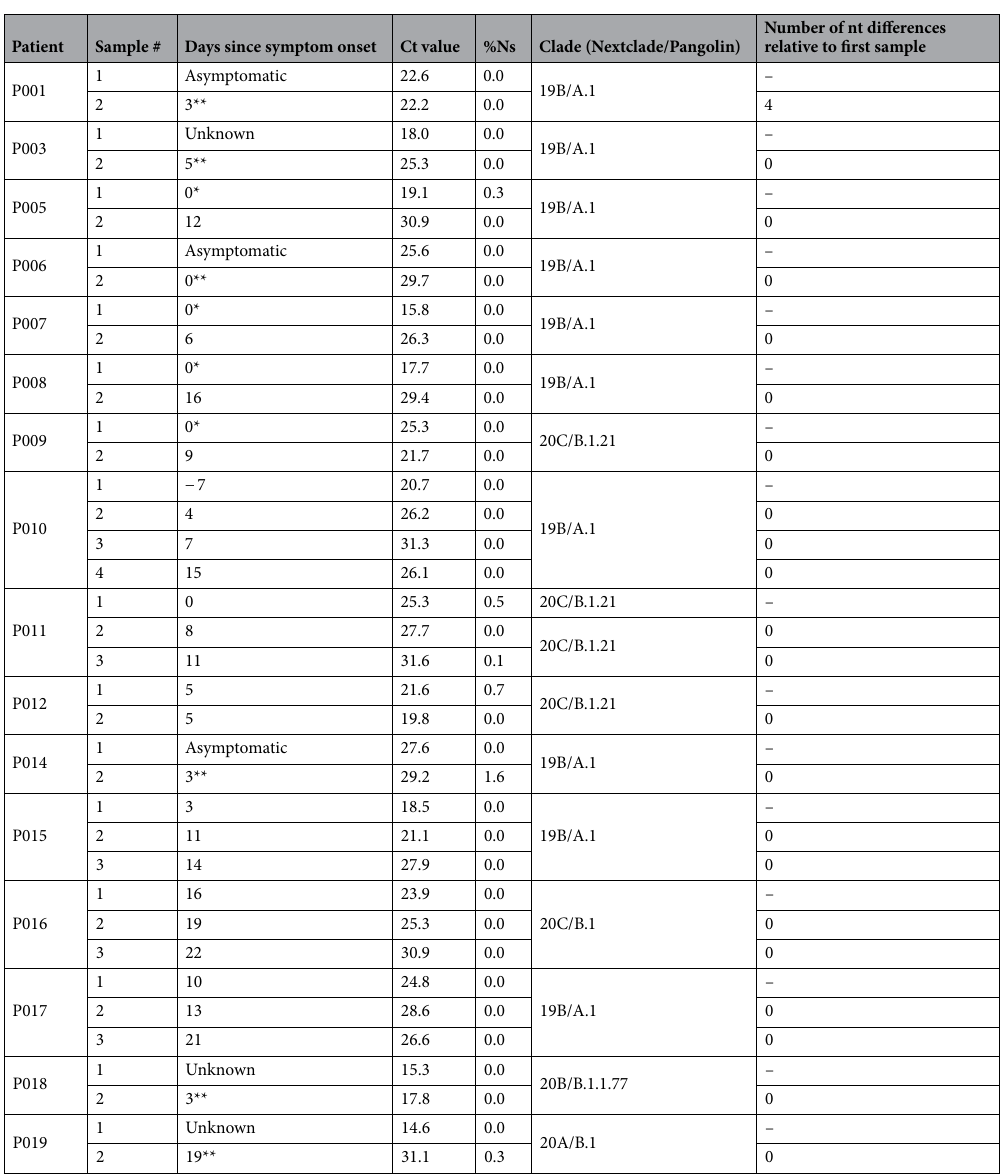
Table 2. Consensus sequence analysis of SARS-CoV-2 in longitudinal specimens. All patients with less than 2% unknown bases (Ns) are included. The last column indicates nucleotide differences compared to the first sample collected for each respective patient. One asterisk (*) indicates symptoms were present at first time point but exact date of symptom onset is unknown. Two asterisks (**) indicate days since first